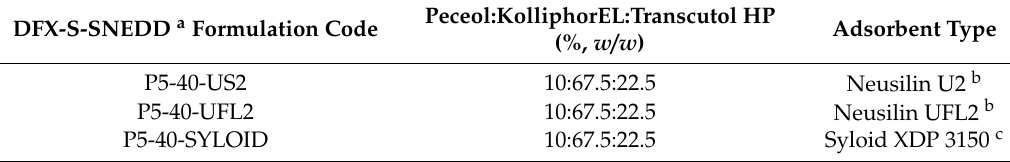
Table 6. Components of DFX-S-SNEDD formulations prepared for further characterization. DFX-S-SNEDD a Formulation